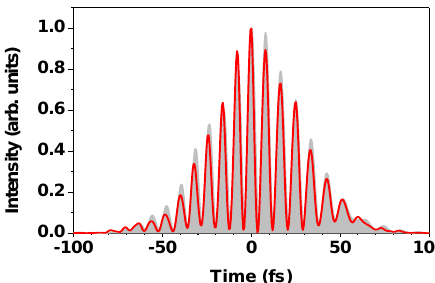
Figure 10. Temporal intensity profiles of the test pulse retrieved from two XFROG traces (solid curve and solid area). One of the two profiles is shifted along the abscissa to match the peak positions of the two profiles for clarity.